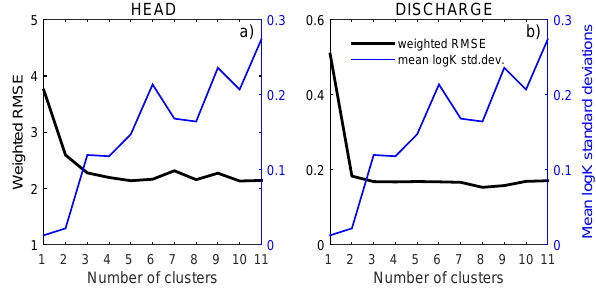
Figure 6. Weighted RMSE of hydrological performance of hydros- tratigraphic models consisting of 1 to 11 clusters. Data are shown for all calibration observations. Blue lines are mean standard devia- tion on log (K)